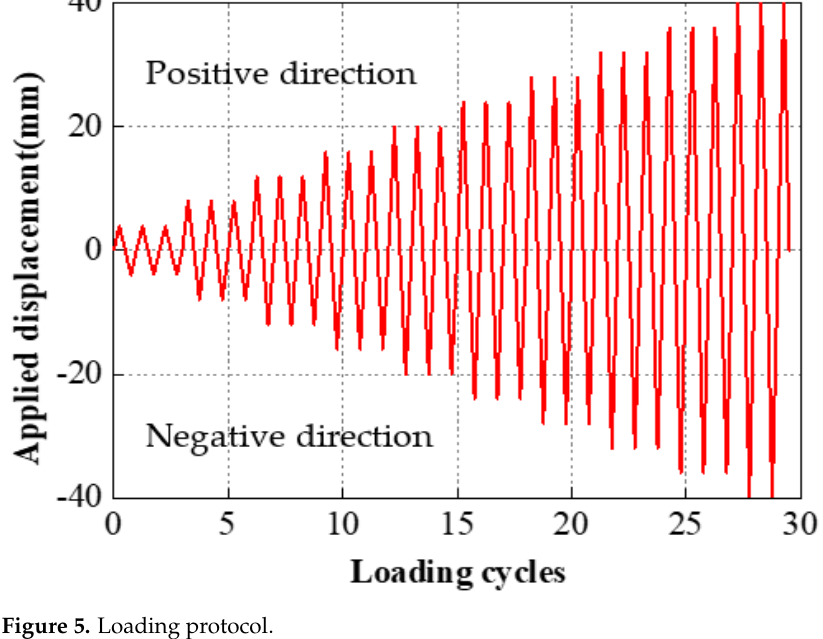
Figure 5. Loading protocol.